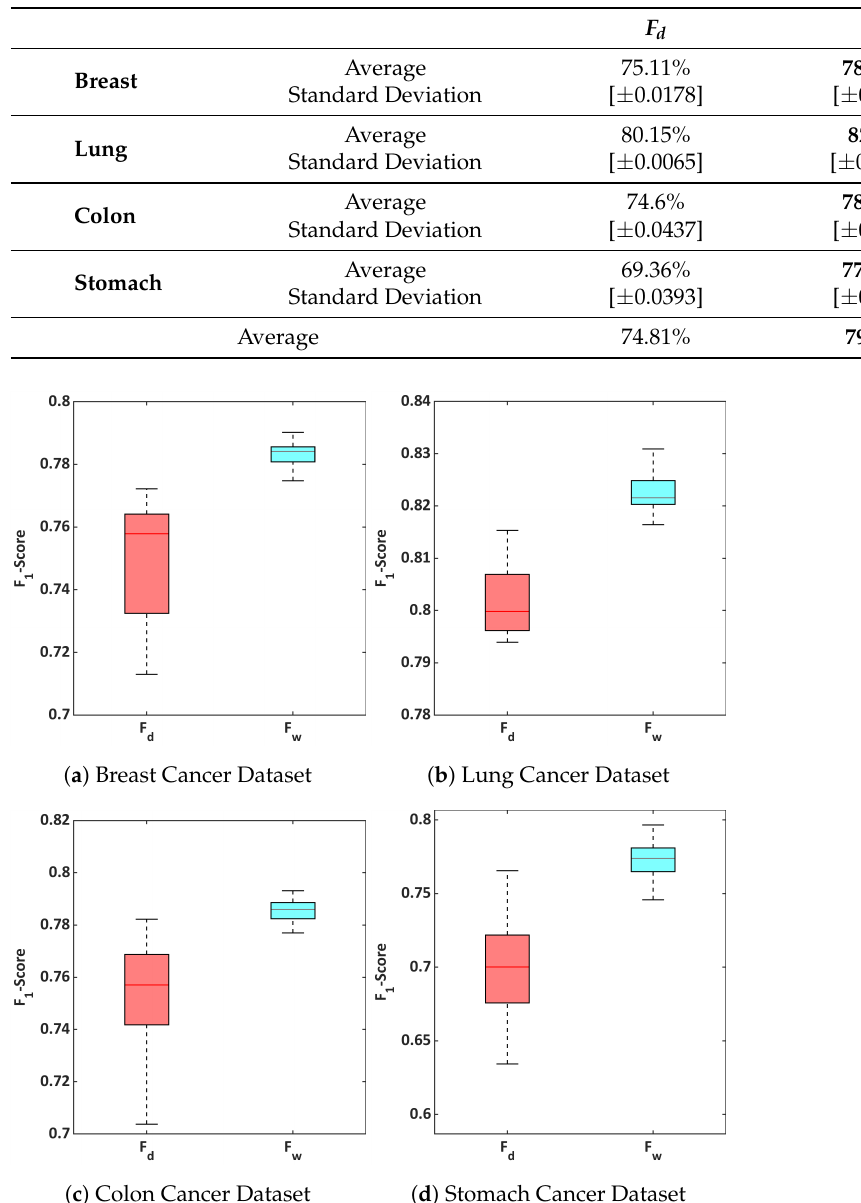
Figure 4. Box plots of the F 1 -Score results obtained by F d and F w for Breast, Lung, Colon, and Stomach Cancer datasets. The red bar inside the box represents the median; the upper whisker represents the maximum value; the lower whisker represents the minimum